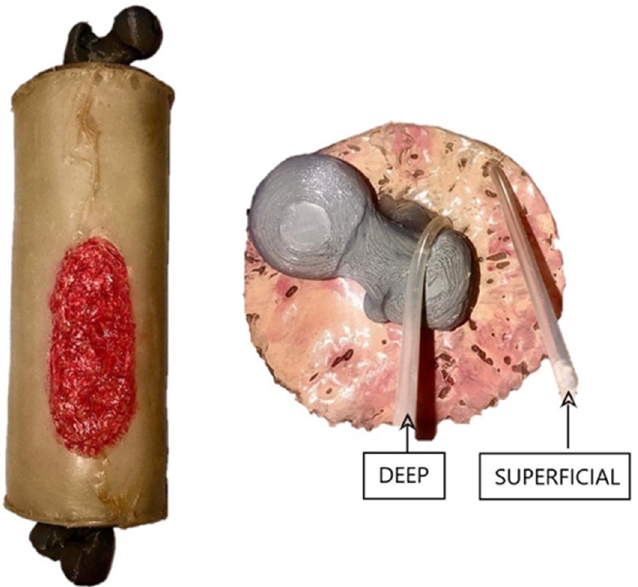
Figure 3. Prototype of the lower limb design and implementation in which the femur, the muscles and the skin are shown. In the left image, the simulator is shown with a lesion in the inferior part of the leg and in the right image, an axial section of the simulator is presented in which the location of different blood vessels is shown.